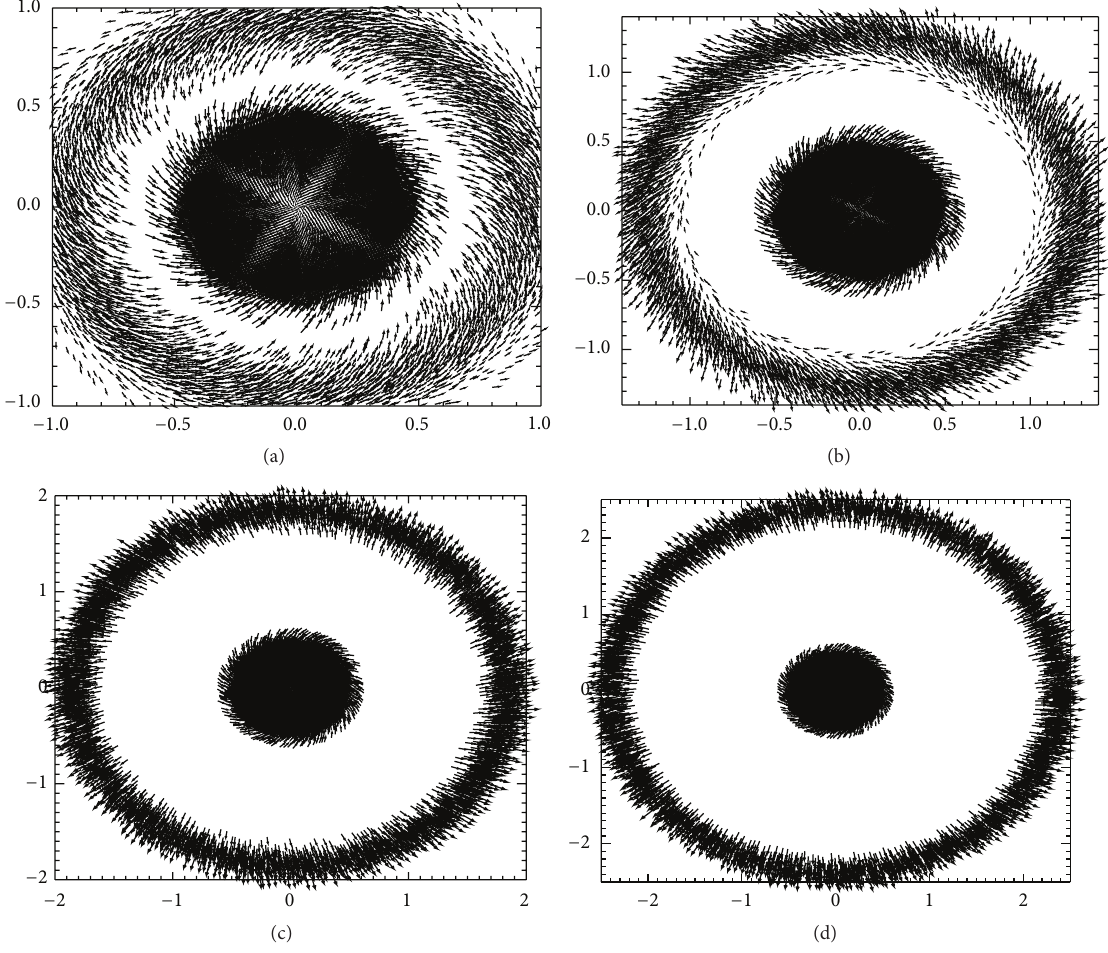
Figure 2: Velocity plots for models A1 to A4, all shown at the same evolution time 4.59 × 10 3